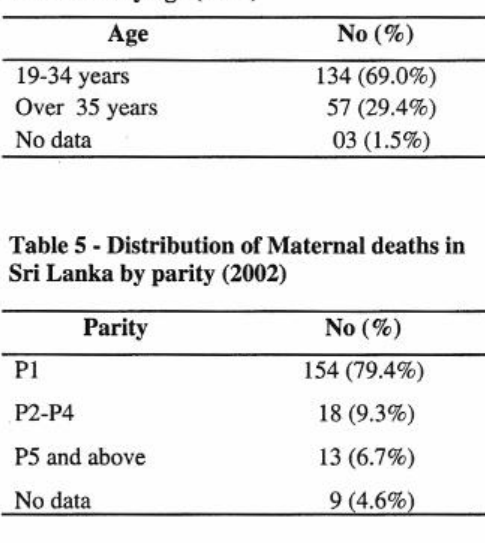
Table 4 - Distribution of Maternal deathsin Sri Lanka by age (2002)